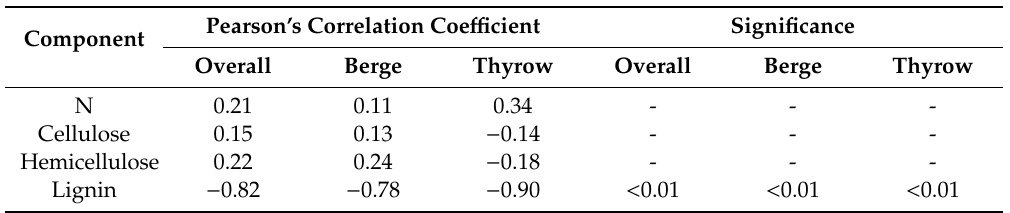
Table 6. Pearson’s correlation coe ffi cients and associated significances (two-tailed t -test) for correlations between mineralized portion (%) of the weighed-in carbon after 178 days and amounts of nitrogen, cellulose, hemicellulose, and lignin per vessel in the soil respiration experiment. Pearson’s Correlation Coe ffi cient Significance Component Overall Berge Thyrow Overall Berge Thyrow N 0.21 0.11 0.34 - - - Cellulose 0.15 0.13 − 0.14 - - - Hemicellulose 0.22 0.24 − 0.18 - - - Lignin − 0.82 − 0.78 −